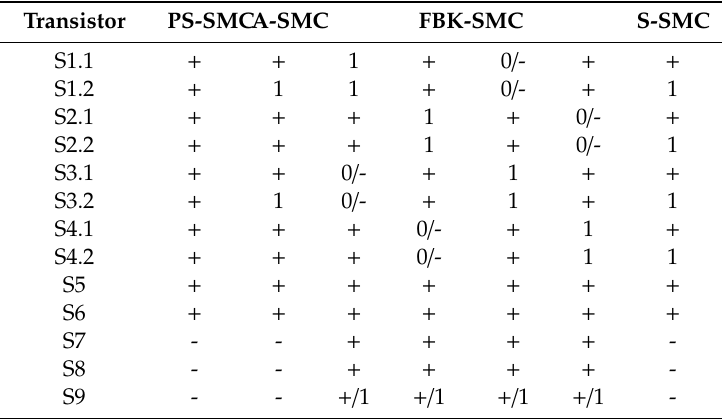
Figure 3. Reconfiguration possibilities of the case study converter: asymmetric secondary-modulated converter (A-SMC): ( a ), flyback secondary-modulated converter (FBK-SMC) ( b ), and symmetric secondary-modulated converter (S-SMC) ( c ). Table 1. Acceptable failures and reconfiguration possibilities A.